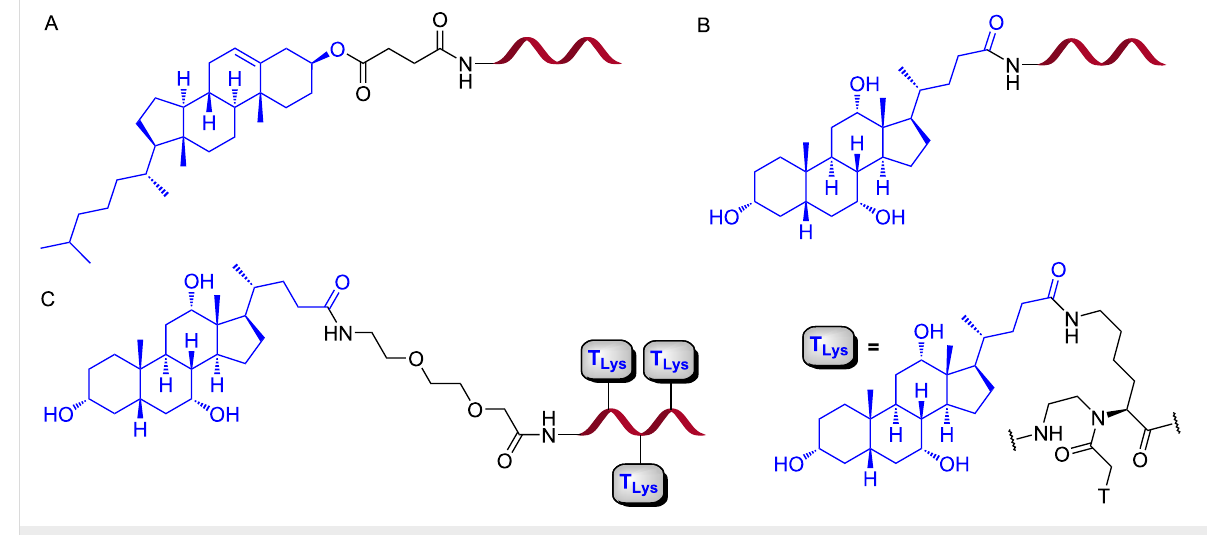
Figure 17: Structures of (A) chloesteryl–PNA, (B) cholate–PNA and (C) cholate–PNA(cholate) 3 .